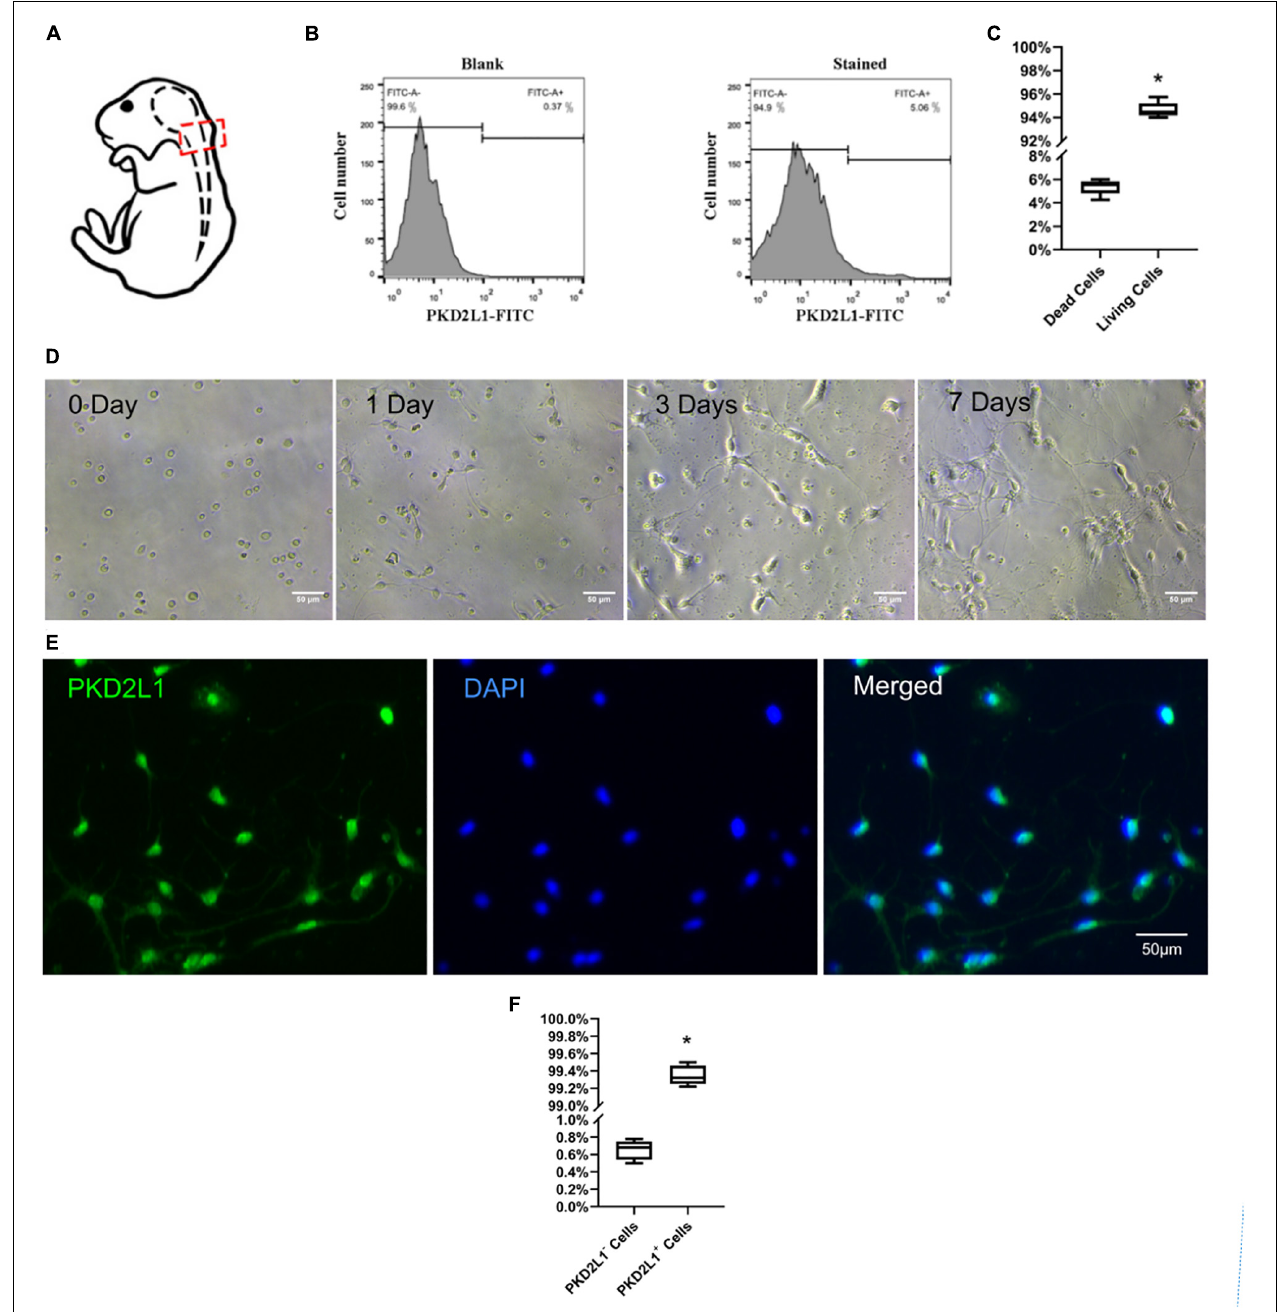
FIGURE 1 | Isolation, culture, and identification of cerebrospinal fluid-contacting neurons (CSF-cNs). (A) A model showing how CSF-cNs were extracted. (B) Fluorescence-activated cell sorting (FACS) analysis of CSF-cNs from the micro-dissected CC zone. (C) The ratio of living/dead cells after FACS. * P < 0.05 verse the dead cells group. (D) FACS-isolated CSF-cNs were cultured from day 0 to day 7. (E) Immunofluorescence analysis (after FACS) on day 7 showing that CSF-cNs expressed polycystic kidney disease type 2 channel 1 (PKD2L1). (F) The ratio of PKD2L1 + /PKD2L1 - cells on day 7 after FACS. * P < 0.05 compared to PKD2L1 - cells